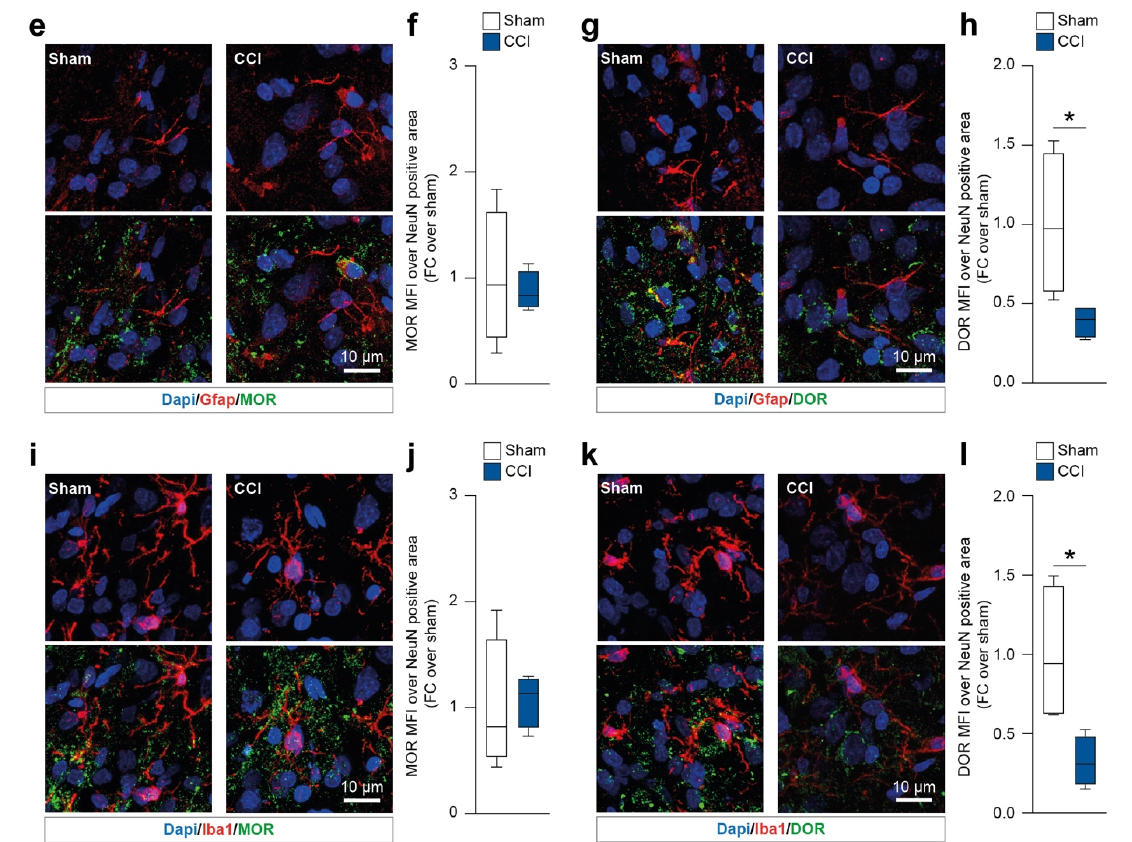
Figure 2. Immunofluorescence analysis of spinal cord resident cell populations expressing mu and delta opioid receptor. ( a , b ) Representative confocal-assisted immunofluorescence pictures of sham-operated and CCI rats ( a ) and quantification of MOR MFI over NeuN-positive cells ( b ). ( c , d ) Representative confocal-assisted immunofluorescence pictures of sham-operated and CCI rats ( c ) and quantification of DOR MFI over NeuN-positive cells (d). ( e , f ) Representative confocal-assisted immunofluorescence pictures of sham-operated and CCI rats ( e ) and quantification of MOR MFI over Gfap-positive cells ( f ). ( g , h ) Representative confocal-assisted immunofluorescence pictures of sham-operated and CCI rats ( g ) and quantification of DOR MFI over Gfap-positive cells ( h ). ( i , j ) Representative confocal-assisted immunofluorescence pictures of sham-operated and CCI rats ( i ) and quantification of MOR MFI over Iba1-positive cells ( j ). ( k , l ) Representative confocal-assisted immunofluorescence pictures of sham-operated and CCI rats ( k ) and quantification of DOR MFI over Iba1-positive cells ( l ). CCI, chronic constriction injury; MOR, mu opioid receptor; DOR, delta opioid receptor; FC, fold change; MFI, mean fluorescence intensity. * p -value < 0.05.